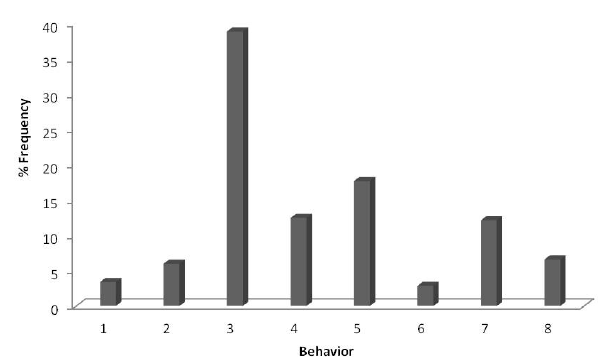
Fig 1 . Percentage of each behavioral act performed by Atta sexdens rubropilosa workers during preparation of the leaf disk substrate and its incorporation into the fungus garden. 1: Transporting the disk to the surface of the fungus garden; 2: holding the disk on the surface of the fungus culture; 3: licking the surface and borders of the leaf disk; 4: cutting the leaf disk into smaller fragments; 5: pleating the borders; 6: deposition of fecal fluid; 7: incorporation into the fungus garden; 8: deposition of hyphae on the incorporated fragments.